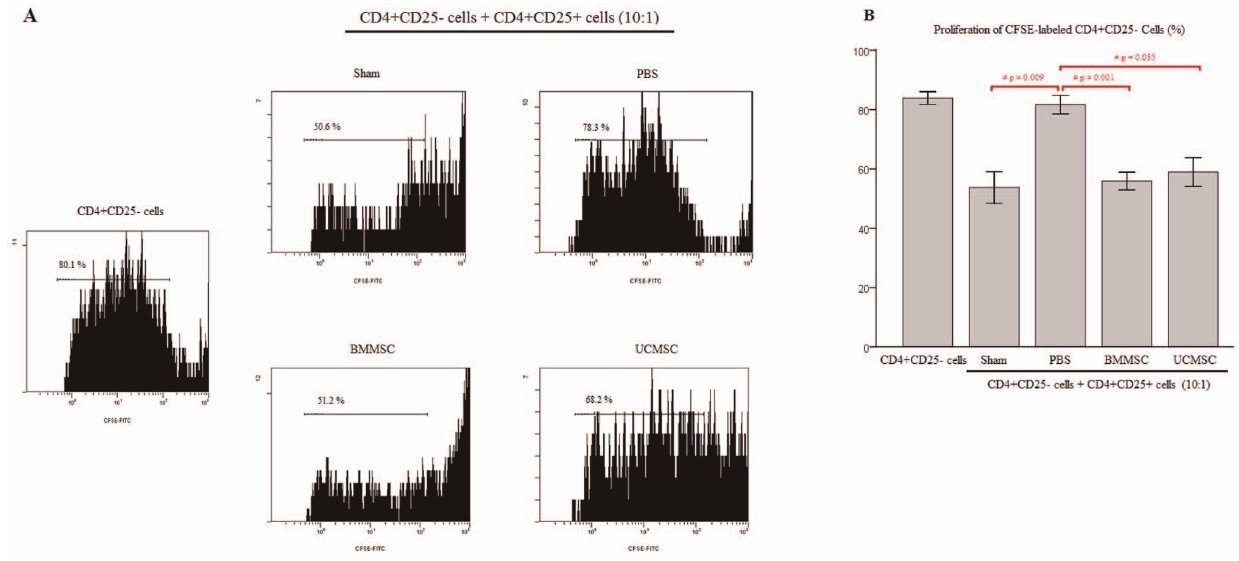
Figure 5. Treg cell suppressive function in rats 18 hours after CLP. ( A ) Analysis of CFSE-labeled CD4 + CD25- cell proliferation by flow cytometry after pre-treatment with a IL-2/CD3/CD28 mixture was shown. ( B ) Proliferation of CFSE-labeled CD4 + CD25- cells was decreased when cocultured with CD4 + CD25 + Treg cells from rats of Sham, BMMSC, and UCMSC groups. The suppressive capacity of CD4 + CD25 + cells from rats receiving PBS only after CLP nearly disappeared. Data are presented as mean 6 SEM. n=6–9 rats/group. # p , 0.05 versus PBS group.